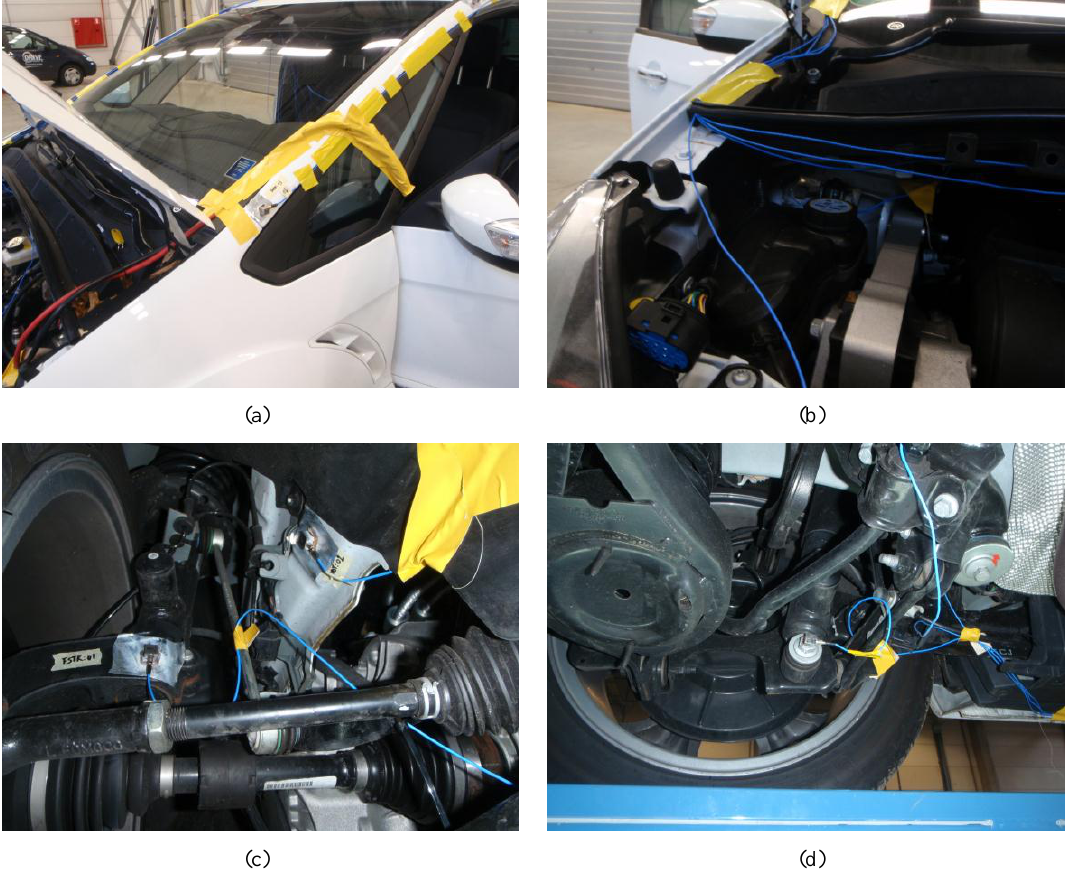
Fig. 2. The acquisition set-up, some sensor locations: On the car body (a), on the front-right suspension, body side (b), on the front-left and rear-right suspensions, wheel side (c,